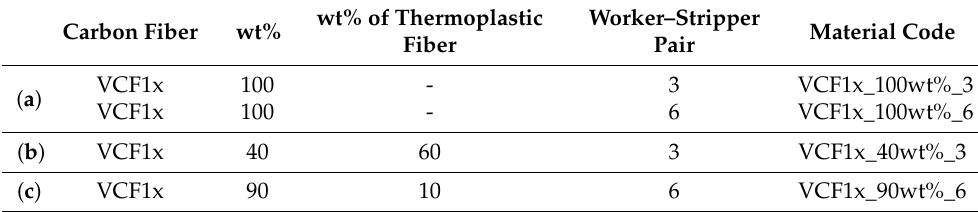
Table 3. Processed fiber blends for fiber length measurement regarding the machine setup. Carbon